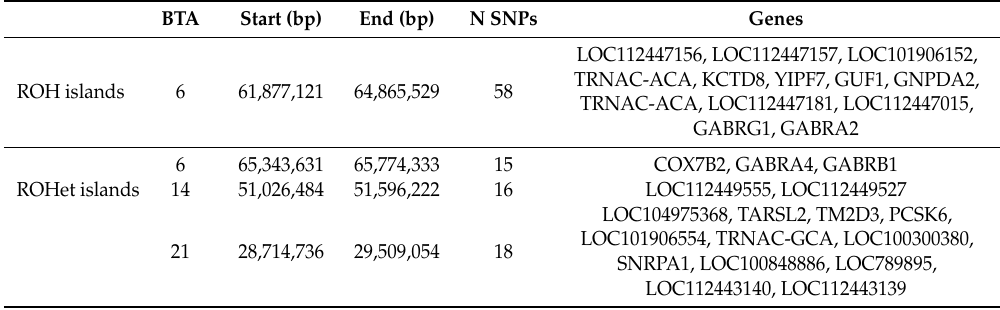
Figure 4. Manhattan plot of the proportion of times each SNP falls within a ROH in the analyzed Maremmana cattle population. The dashed horizontal line is the 41% threshold obtained from the SNP homozygosity distribution. Table 3. ROH and ROHet islands detected in Maremmana cattle. Non-annotated loci are indicated with the prefix